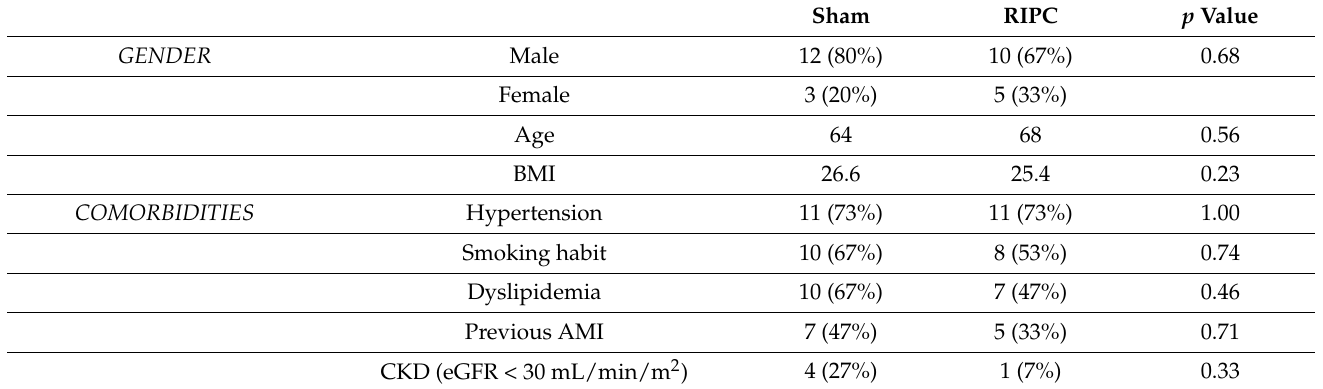
Figure 1. Clinical study protocol. Patients included in the trial were randomly assigned to the RIPC or sham procedure. EVs were isolated from serum samples after the PCI procedure. Table 1. Patients’ clinical features at baseline.